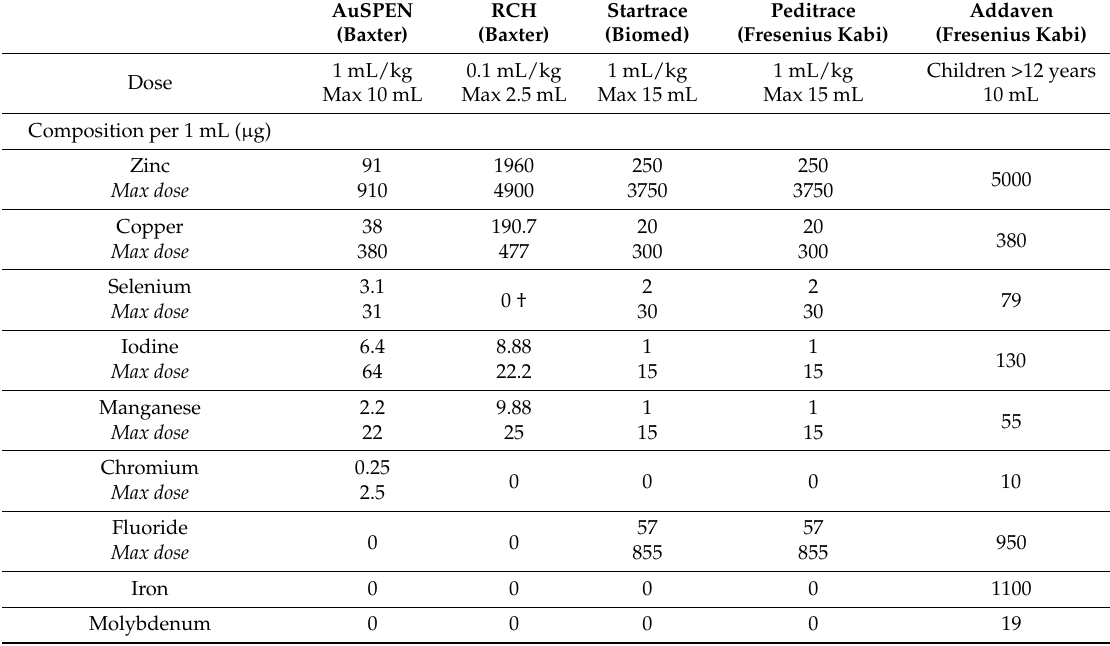
Table 2. Composition of commercial pediatric trace element solutions available in Australia and New